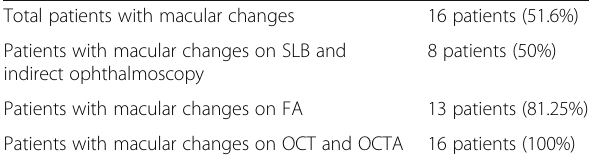
Table 2 Number of patients with macular changes Total patients with macular changes